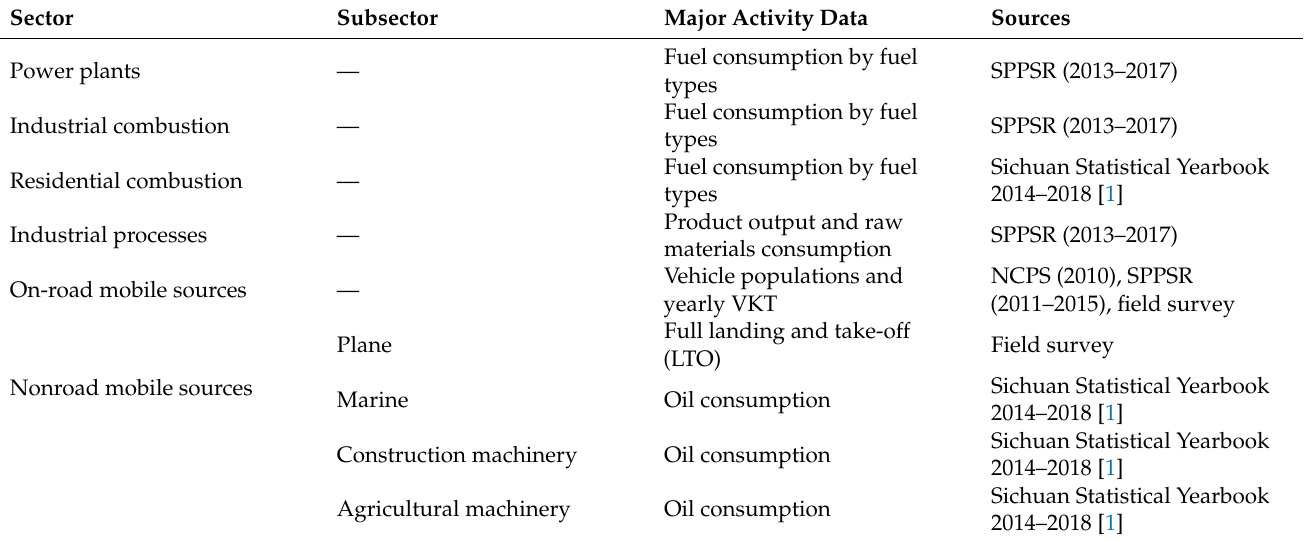
Table 3. Activity data for major emission